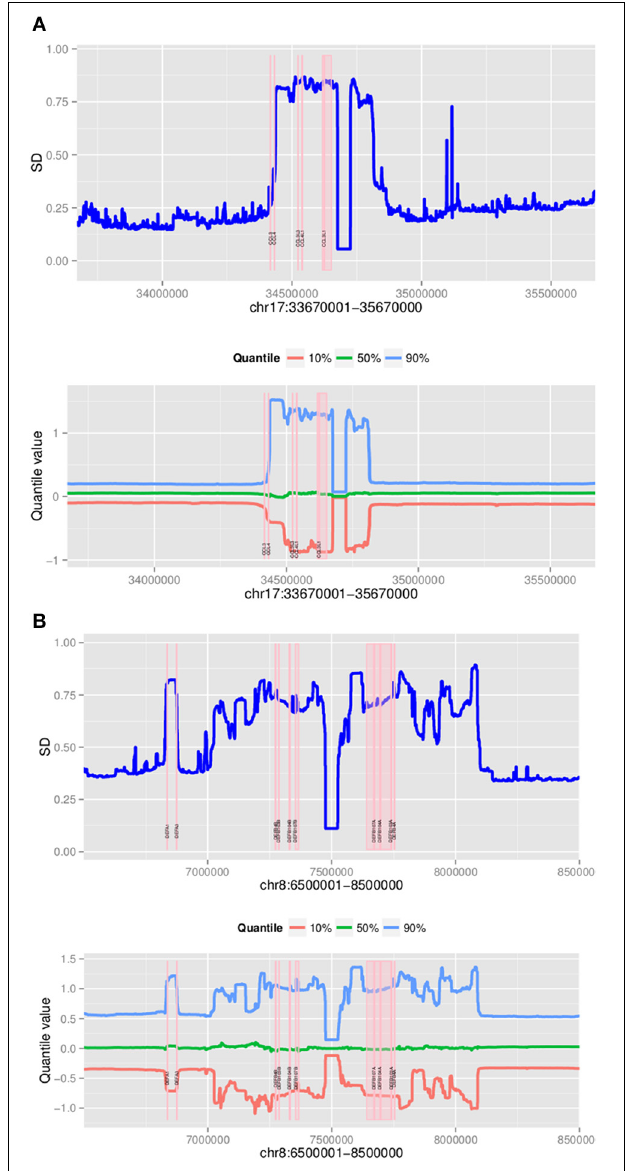
FIGURE 7 | Plots of polymorphic regions encompassing CCL3L1 (A) and DEFB103A (B). The plots show standard deviation (top) and different percentiles (bottom) across 2Mb sub-regions (for all 2535 samples).